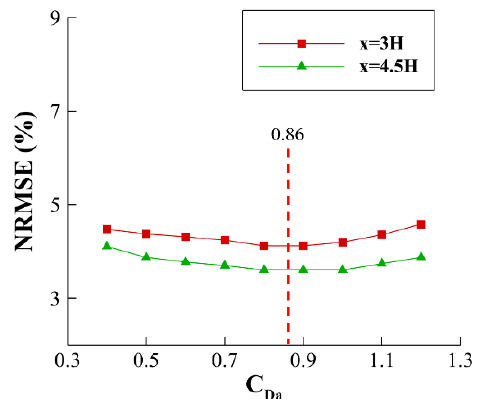
Figure 7. Variation of normal root-mean-square errors.